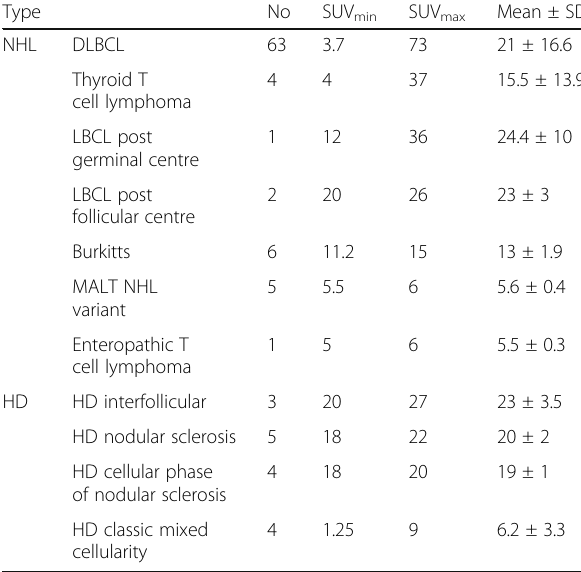
Table 4 Agreement between PET/CT and CECT in detection of extranodal lymphomatous